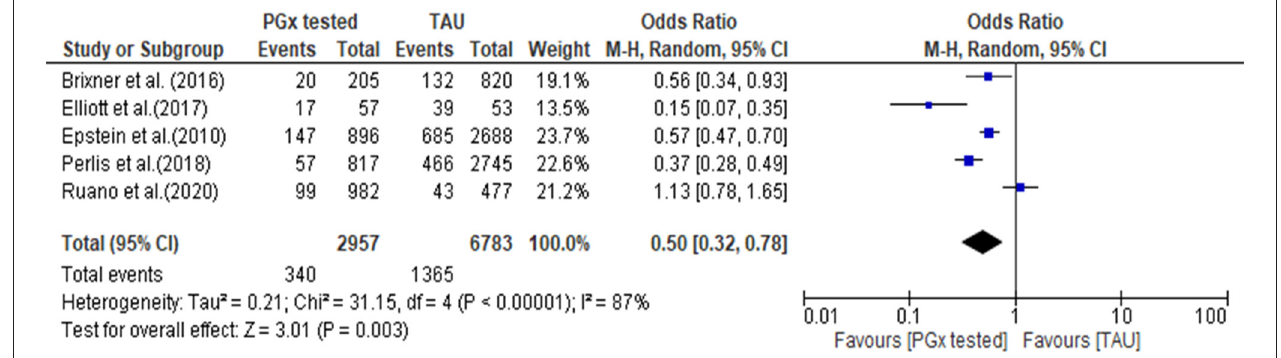
FIGURE 5 | Forest plot showing the effect of PGx testing on hospitalization compared to treatment-as-usual. 95% CI, 95% confidence interval. The number of “events” are the number of participants who were hospitalized during the reporting period of the